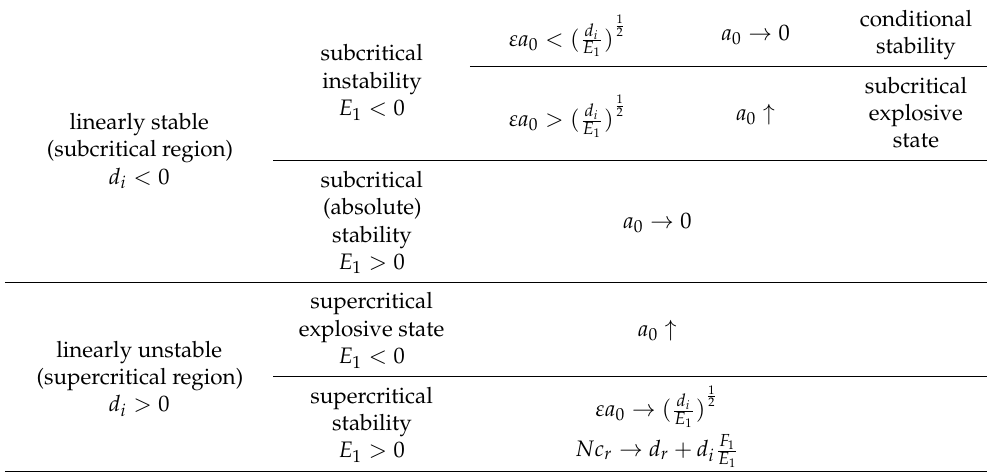
Table 1. Various states of the Landau